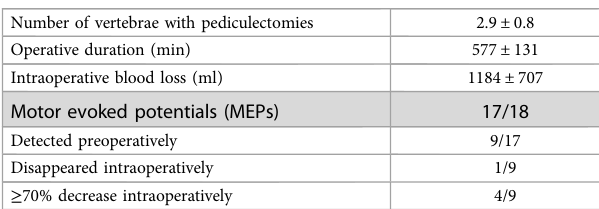
TABLE 2 Intraoperative data of our modi fi ed ohtsuka procedure.